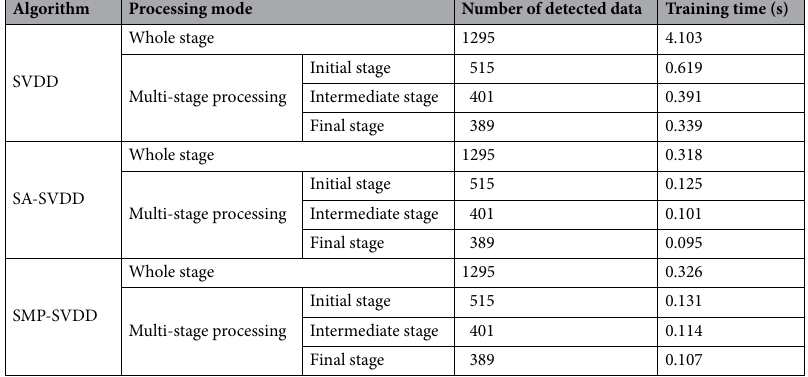
Table 5. Comparison of training time of different